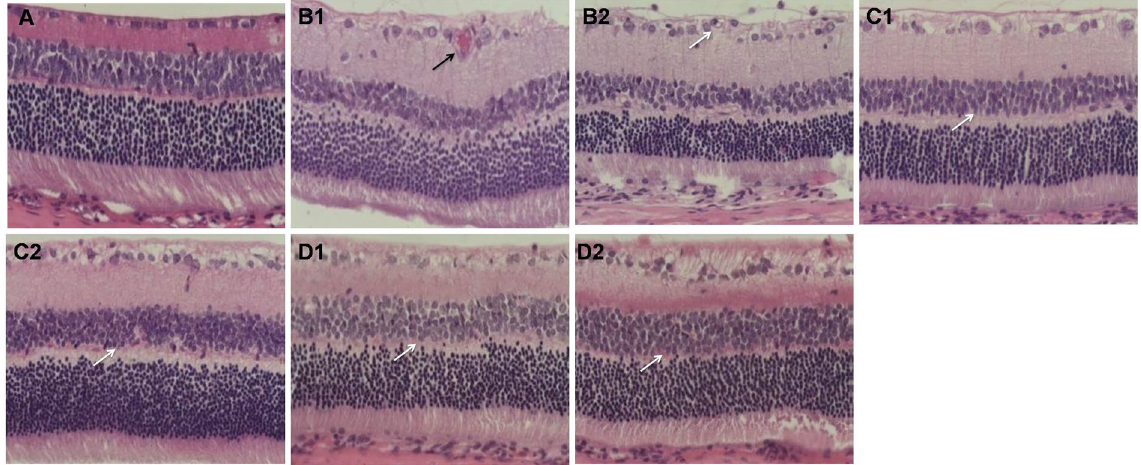
Figure 1. ( A ) Retinal HE staining in Group A. The retinal structure was continuous, and its capillary structure was normal. HE 200 × . ( B1 – 2 ) Retinal HE staining in Group B. The tissue layers of the retina were edematous, and the retina developed telangiectatic vessels (black arrow). Many ganglion cells developed vacuolar degeneration (white arrow) at 4 weeks ( B1 ) and 8 weeks ( B2 ). HE 200 × . ( C and D ) Retinal HE staining in Groups C and D. Treatment with MSCs and NSCs attenuated the retinal vascular dysfunction, and the tissue layers of the retina were gradually arranged regularly (white arrow) at 4 weeks and 8 weeks. HE 200 ×